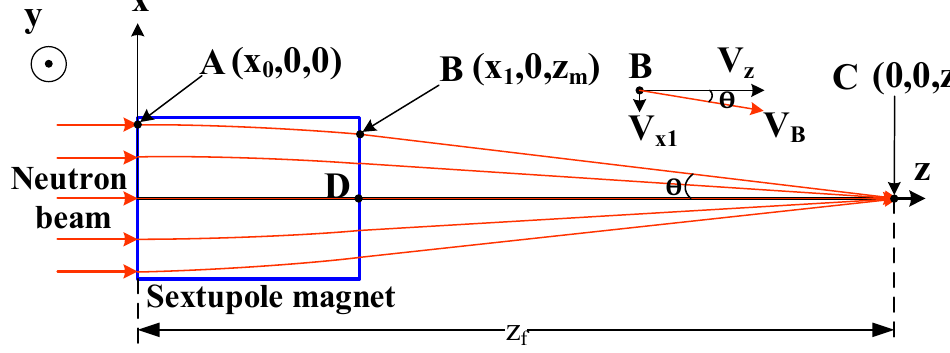
Figure 2. Focusing geometry of the sextupole magnet.